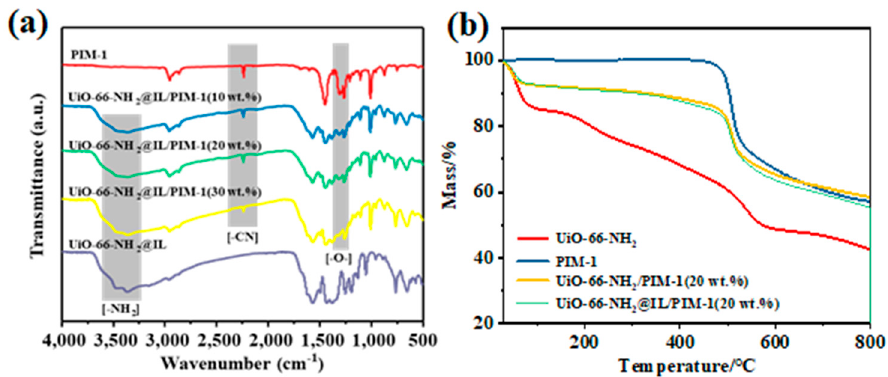
Figure 5. ( a ) FTIR spectra of pure PIM-1 membrane and UiO-66-NH 2 @IL/PIM-1 MMM, ( b ) TGA of UiO-66-NH 2 powder, PIM-1 membrane, UiO-66-NH 2 /PIM-1 membrane and UiO-66-NH 2 @IL/PIM-1 membrane.